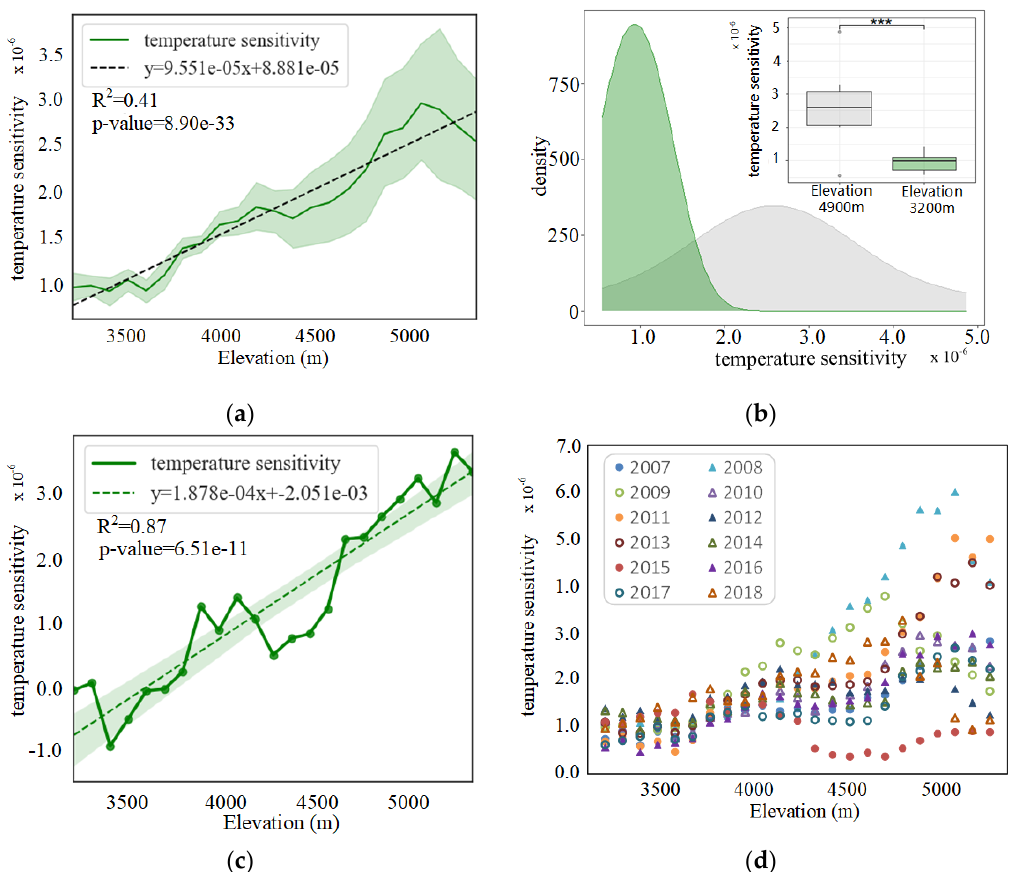
Figure 6. ( a ) Seasonal temperature sensitivity along altitudinal gradient, derived from annual cycle. ( b ) Distribution of temperature sensitivity at 4900–5000 m (in blue) and 3200–3300 m (in gray), showing significant differences between them. ( c ) Interannual temperature sensitivity along altitudinal gradient; different from results in Figure 5a, temperature sensitivity calculated here does not distinguish differences in DOYs, and shows a generally positive relationship between SIF yield and temperature (positive temperature sensitivity) at interannual scale in most regions. ( d ) Altitudinal variation in temperature sensitivity in different years. Shaded areas represent the 95% confidence interval and the unit of temperature sensitivity is nm –1 sr –1 K –1 .